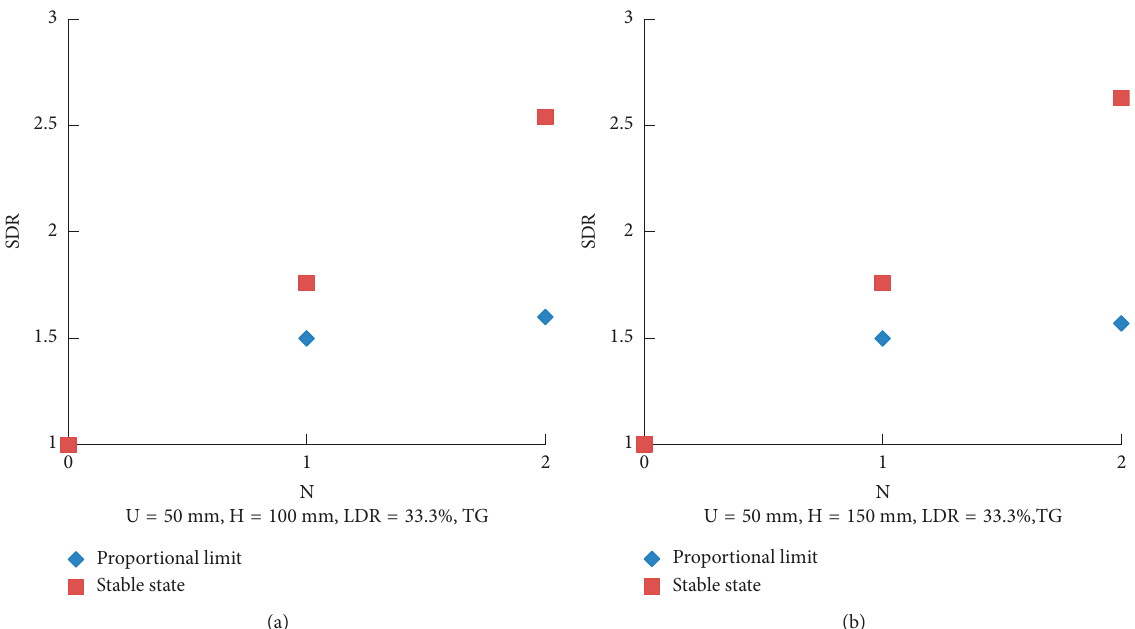
Figure 16: The relationships between SDR and N : (a) TG, U LDR 33.3%. (cid:30)